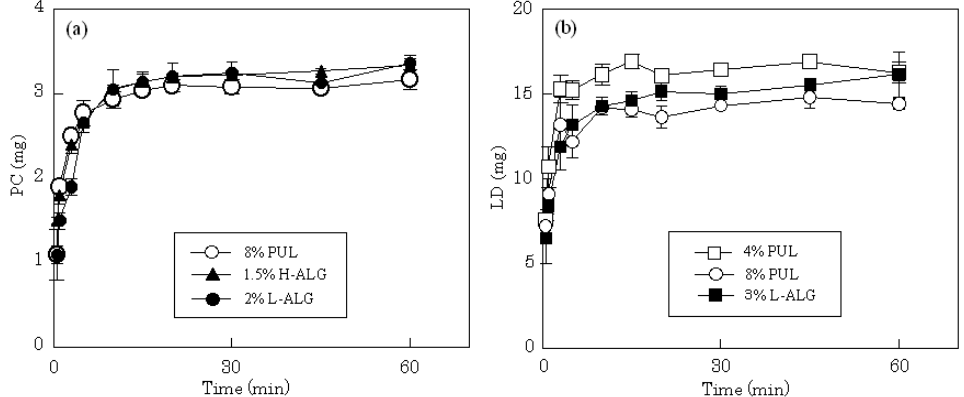
Figure 3. Release profiles of PC (a) and LD (b) from FDFs in physiological saline.